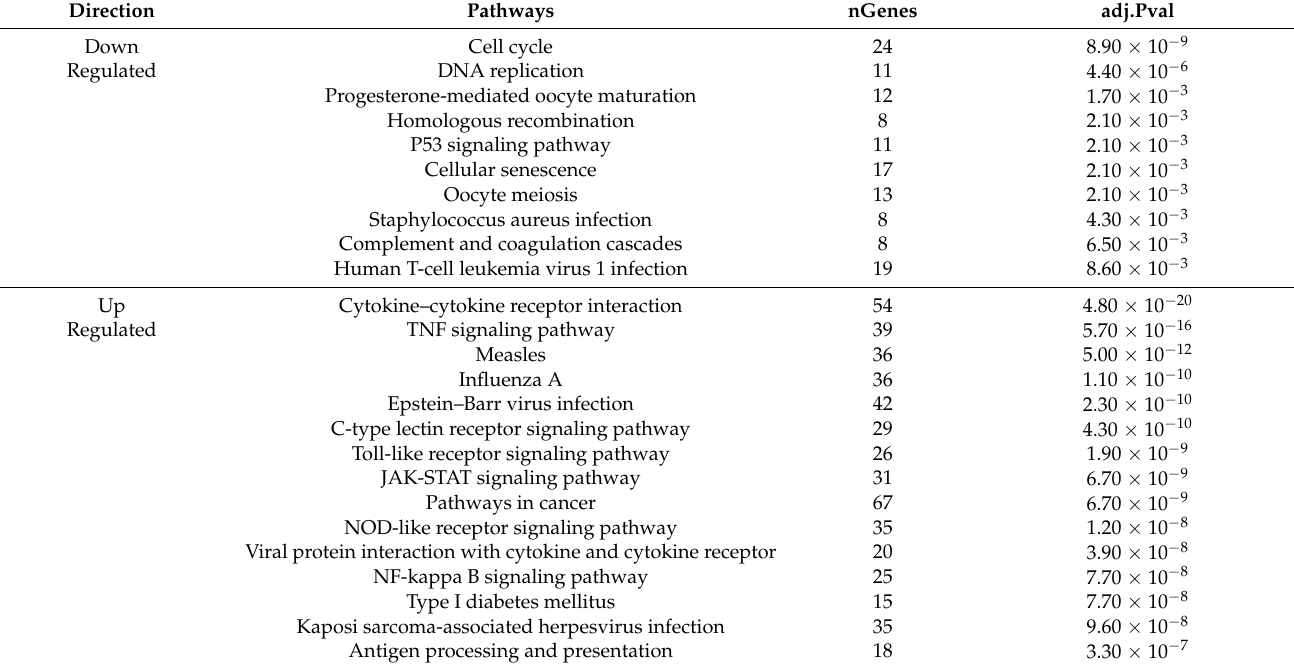
Table 1. Enriched KEGG pathways among genes up- and down-regulated by fucoidan